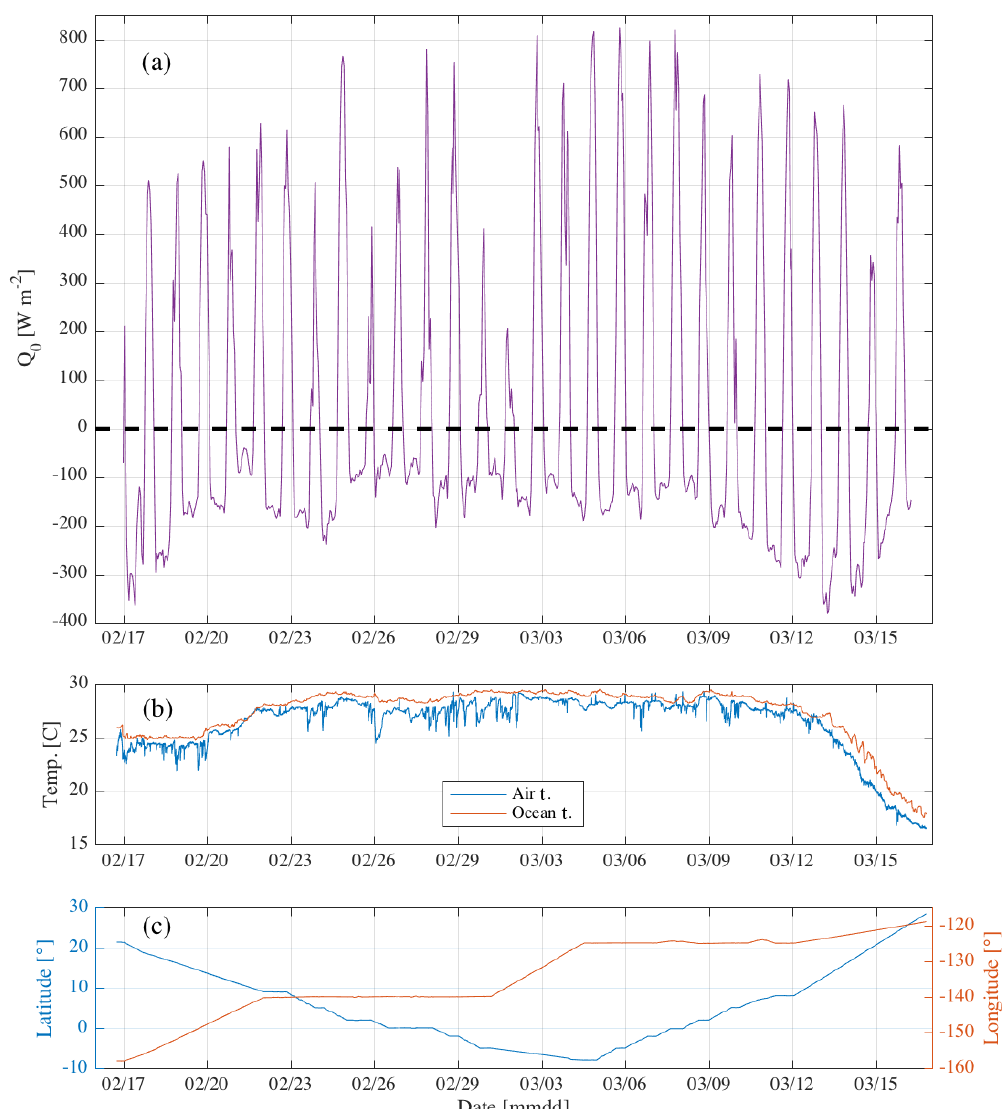
Figure 20. (a) 1h average ocean net surface heat flux ( Q 0 ) along NOAA Ship Ronald H. Brown ’s track from 16 February to 17 March 2016. The flux is based on a combination of measurements and calculations with the COARE bulk flux algorithm. (b) For the same time period, 1min average ocean temperature at 5m depth, and air temperature. (c) Ship